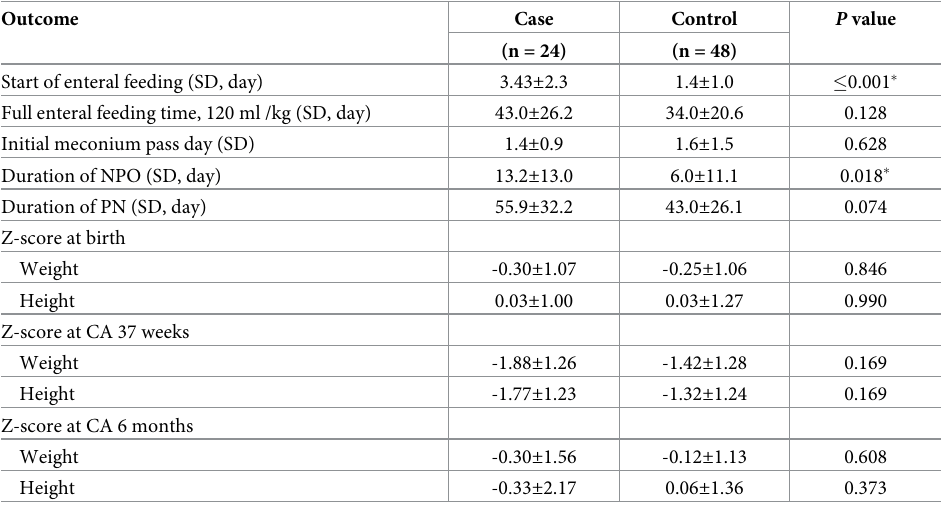
Table 4. Comparison of growth and feeding progress between case and control group. Outcome Case Control P value